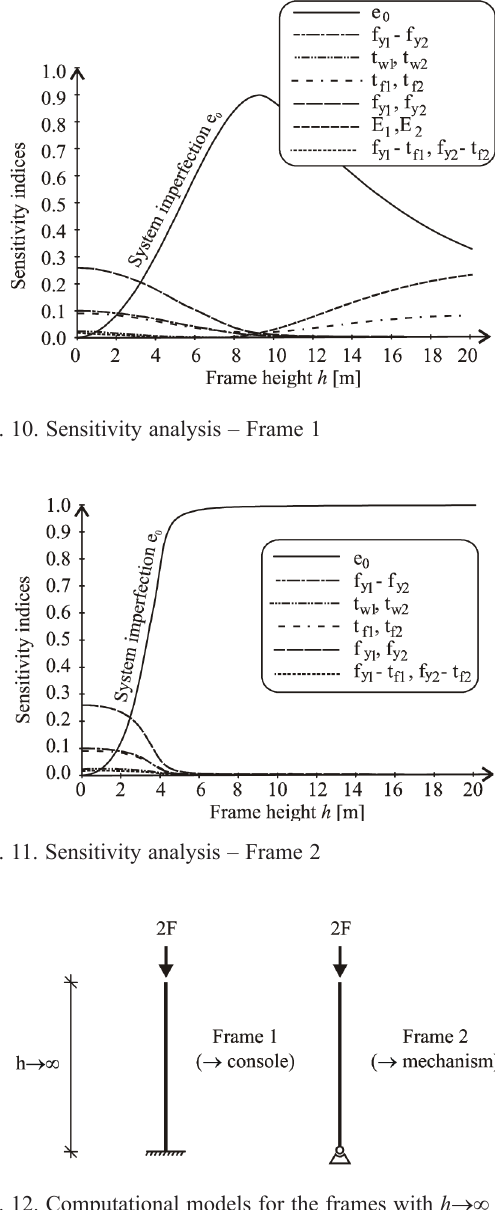
Fig. 12. Computational models for the frames with h